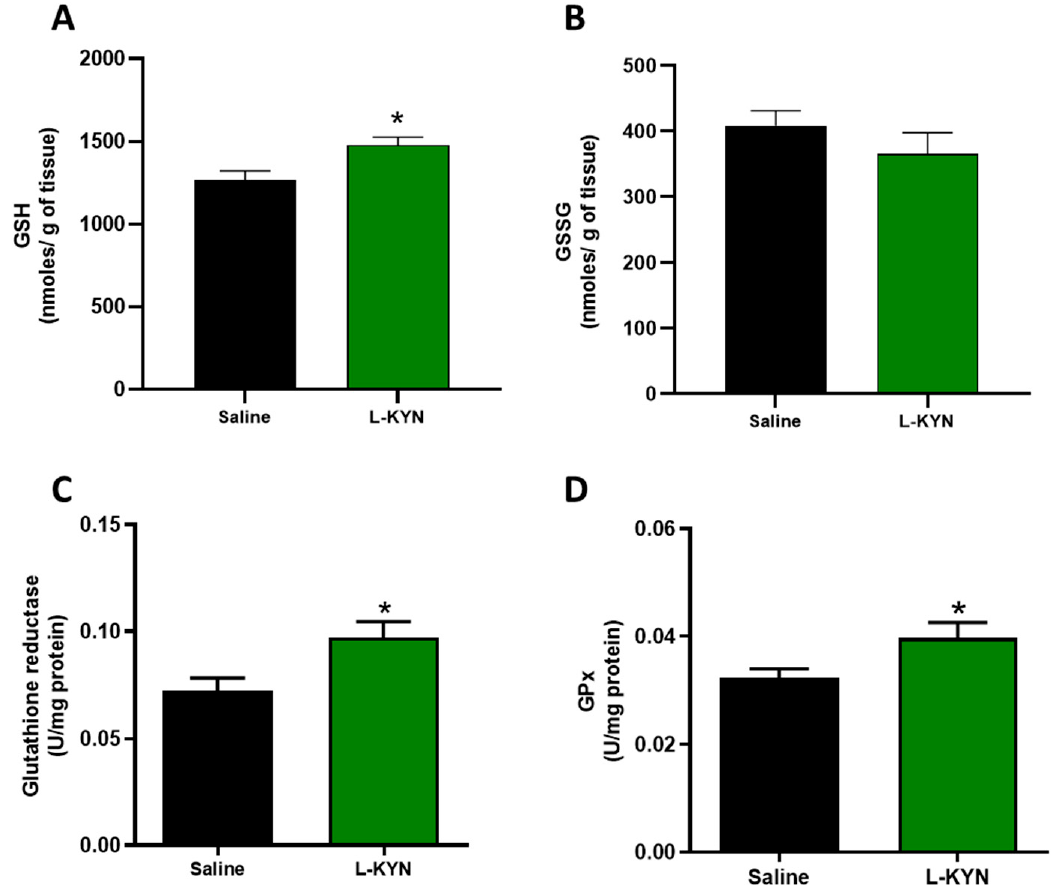
Table 4. Kynurenine metabolites brain levels.